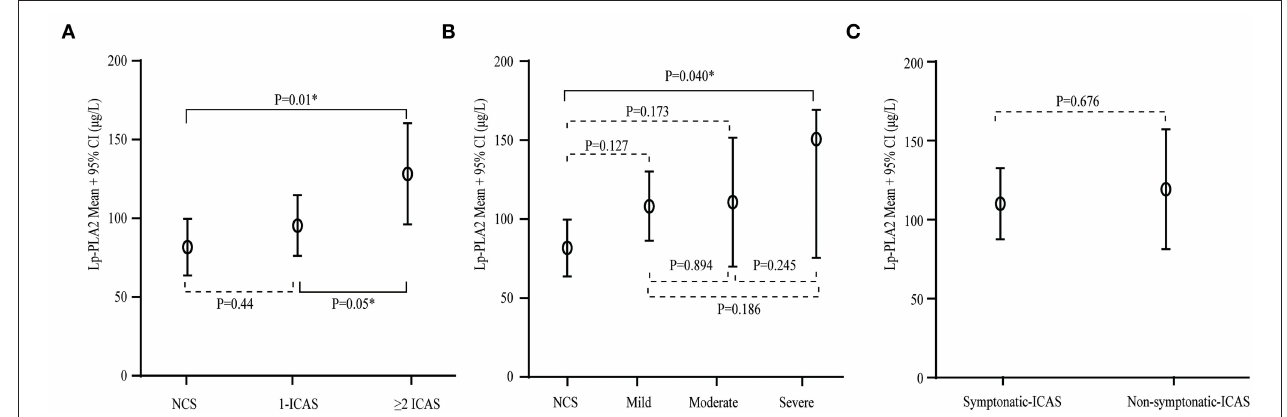
FIGURE 3 | Serum Lp-PLA2 levels and the severity of stenosis in ICAS. (A) Serum levels of Lp-PLA2 levels according to the number of ICAS. Compared with those with one lesion and with no arterial stenosis, Lp-PLA2 levels in patients with two or more lesions were higher. (B) Serum levels of Lp-PLA2 levels according to the severity of stenosis of ICAS. Lp-PLA2 levels in patients with severe ICAS were relatively higher than in those with moderate or mild ICAS. (C) Serum levels of Lp-PLA2 levels according to symptomatic and asymptomatic ICAS. There was no difference in the Lp-PLA2 level between patients with asymptomatic and symptomatic